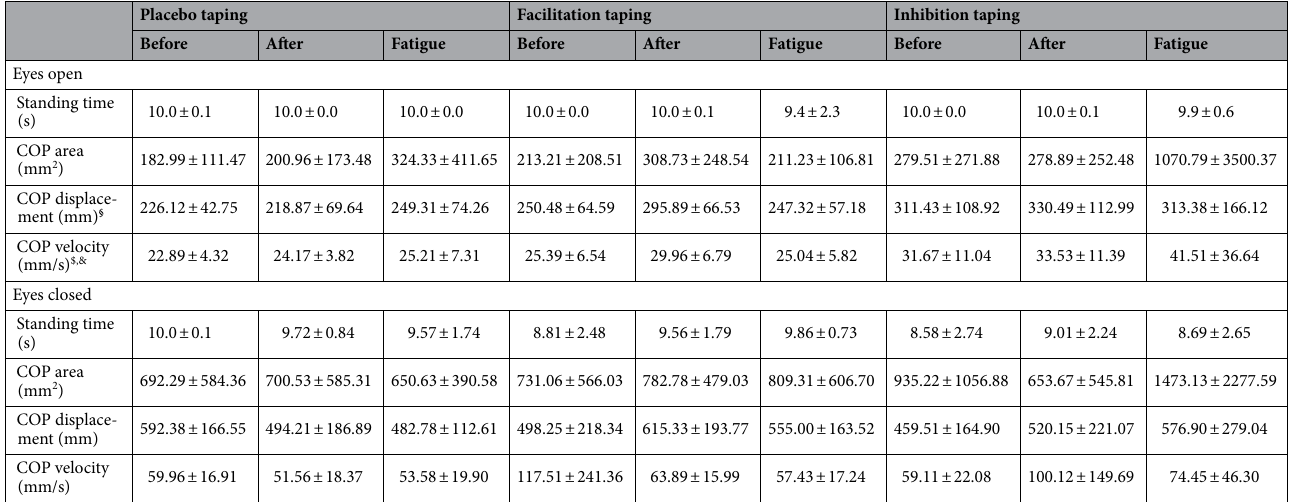
Table 1. The balance data of three taping groups on barefoot with eyes open and eyes closed condition. § Significant difference between Inhibition taping group and Placebo taping group in before, immediate after taping and after fatigue exercise. $ Significant difference between Inhibition taping group and Placebo taping group in before, immediate after taping and after fatigue exercise. & Significant difference between Inhibition taping group and Facilitation taping group in before, immediate after taping and after fatigue exercise.